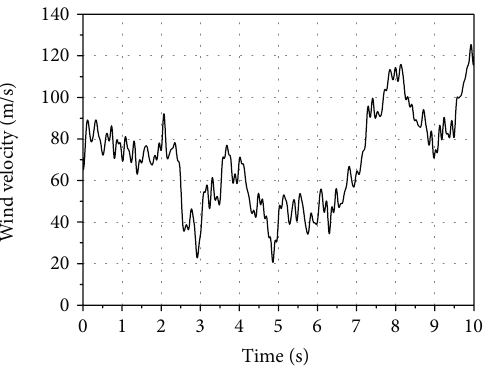
Figure 2: Continuous gust time domain